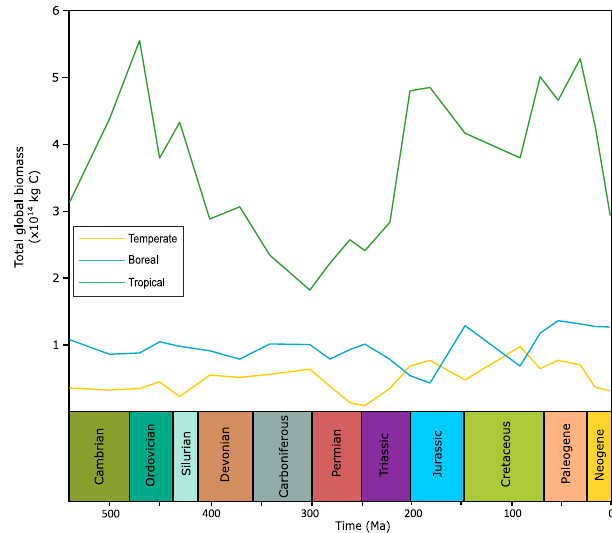
Fig. 7 | Potential biomass of plant functional types across the Phanerozoic. TropicalplantfunctionaltypebiomassdominatesacrossthePhanerozoicandisthe driver for the key changes in our global potential biomass predictions. Ma: million years